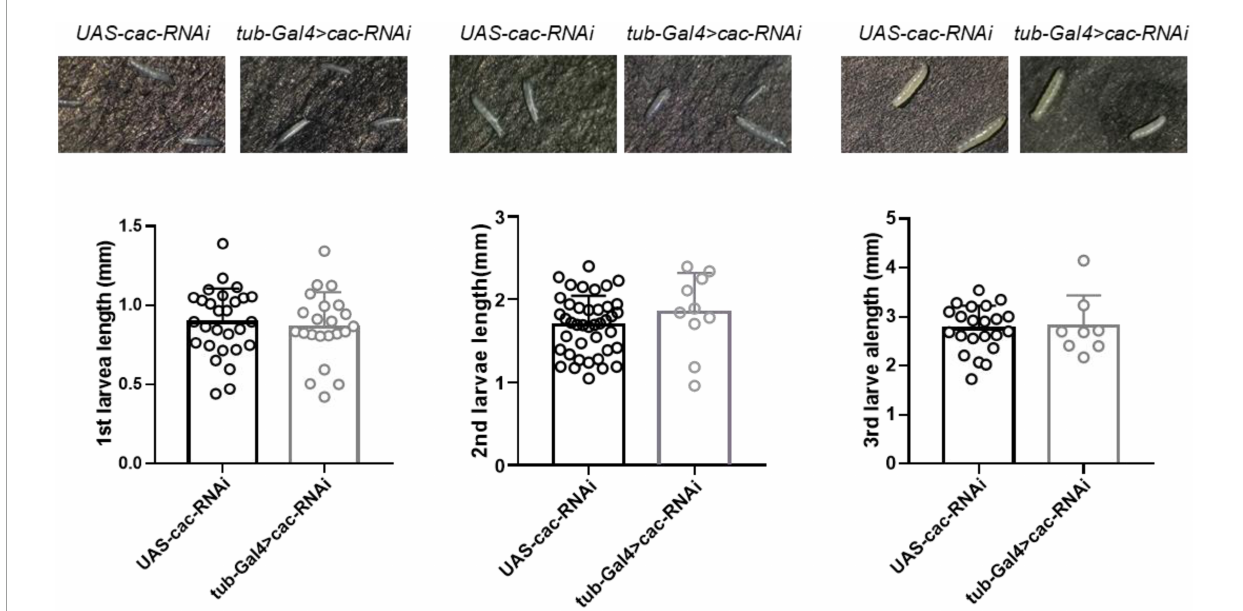
FIGURE4 Global knockdown of calcium channel (cac) did not affect the development of Drosophila . The length of the 1st, 2nd, and 3rd larval stages did not show significant differences between wild-type files UAS-Cac-RNAi and calcium channel knockdown flies tub-Gal4 > cac-RNAi